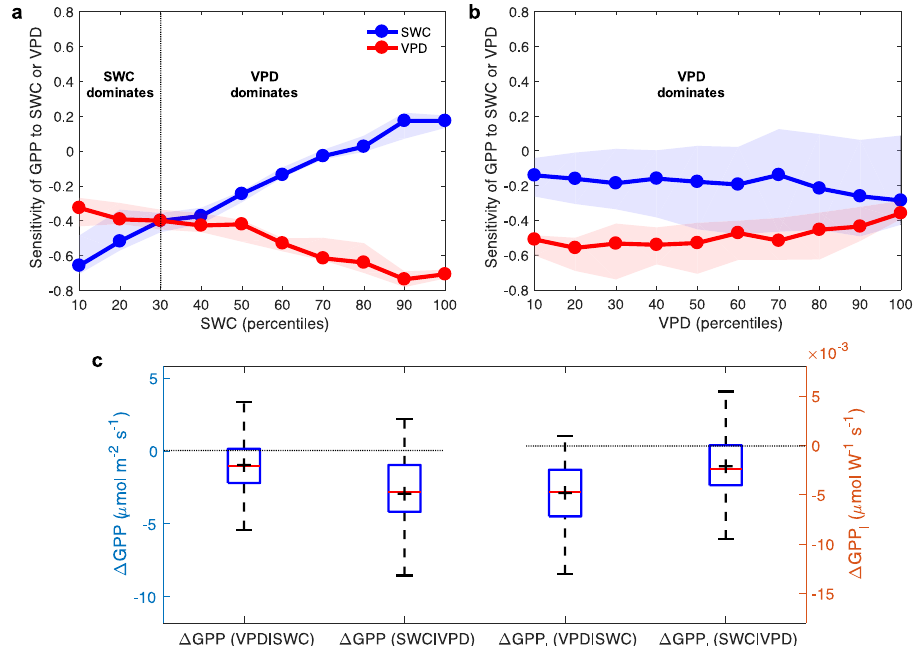
Fig. 3 Disentangling soil water content and vapor pressure de fi cit limitation effects. a The sensitivity of gross primary production (GPP) to soil water content (SWC) or vapor pressure de fi cit (VPD) at each SWC bin. b The sensitivity of GPP to SWC or VPD at each VPD bin. The solid lines indicate the median values and the uncertainty bounds refer to the range from 25th to 75th percentiles. c Effect of low SWC and high VPD on GPP using the approaches of Liu, Gudmundsson 5 across all sites. The terms are de fi ned following Liu, Gudmundsson 5 . Δ GPP (VPD|SWC): VPD limitation on GPP without SWC-VPD coupling; Δ GPP(SWC|VPD): SWC limitation on GPP without SWC-VPD coupling. GPP I means GPP is normalized by incoming (I) shortwave radiation to remove the radiation effects. For each box plot, the ‘ + ’ indicates the mean; the box indicates the upper and lower quartiles and the whiskers indicate the 5th and 95th percentiles of the